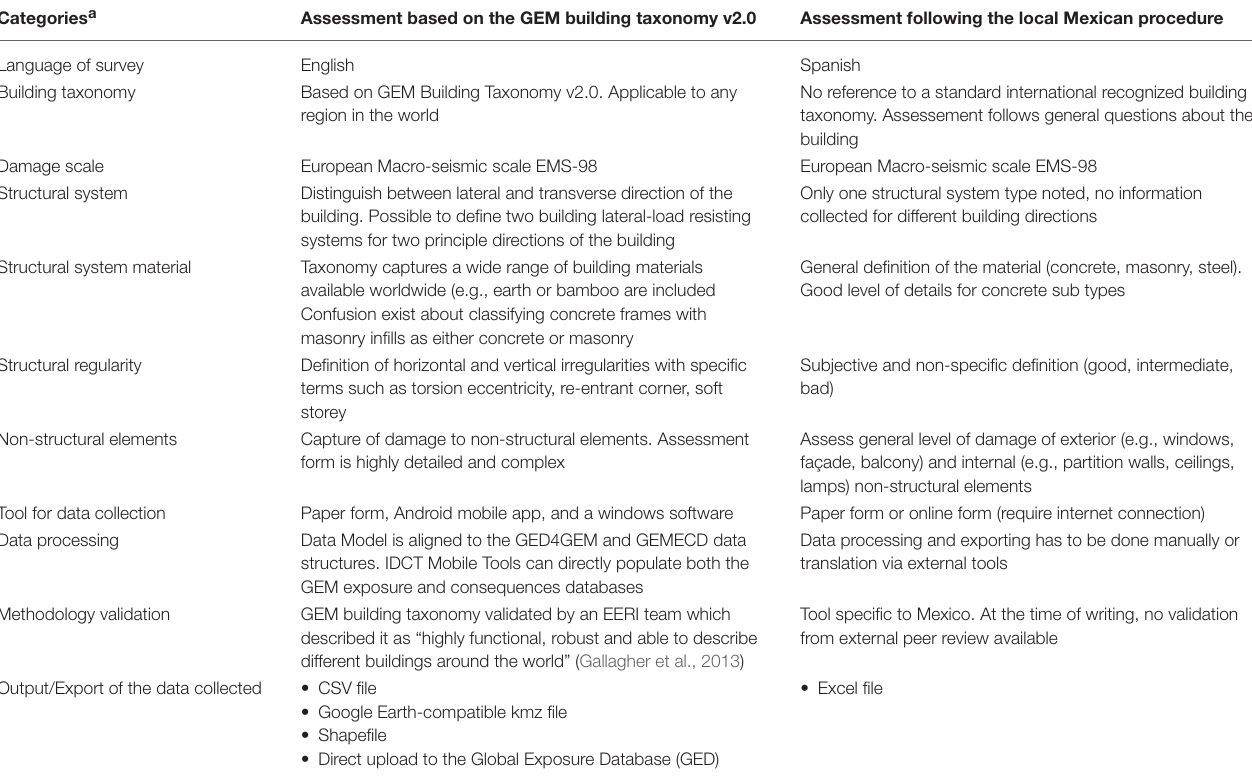
TABLE 2 | Comparison of the GEM assessment methodology vs. the local Mexican